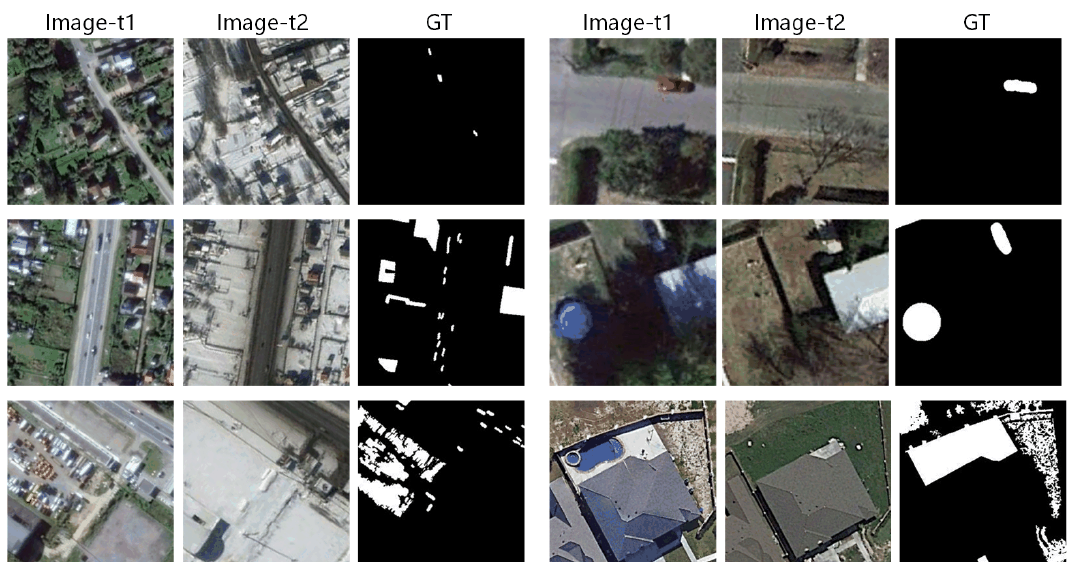
Figure 3. Illustration of samples from LEBEDEV. The selected bi-temporal image pairs with GT show the change including cars, buildings, surface uses, etc. The seasonal appearance difference is not considered as change. The changed area/object is marked with white pixels in GTs. It can be observed that, generally, the positive pixels are less than the negative pixels. The numbers and shapes of the changed regions are various, distributing loosely or densely, also with noises